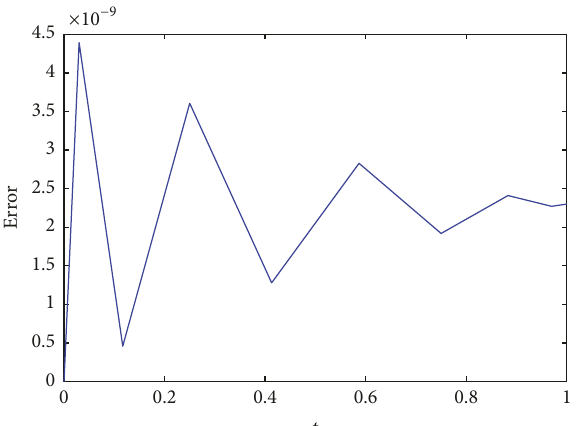
Figure 9: Absolute error of the explicit spectral PIM for 𝑁 = 10 and ℎ = −0.8 for Example